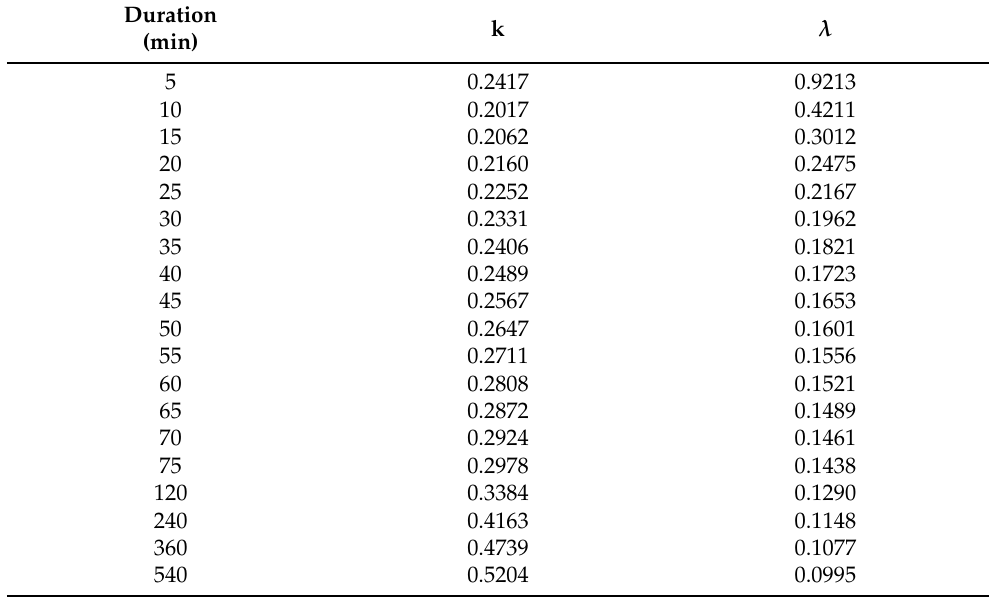
Table 3. Fitting parameters of the Gamma distribution for every duration t d